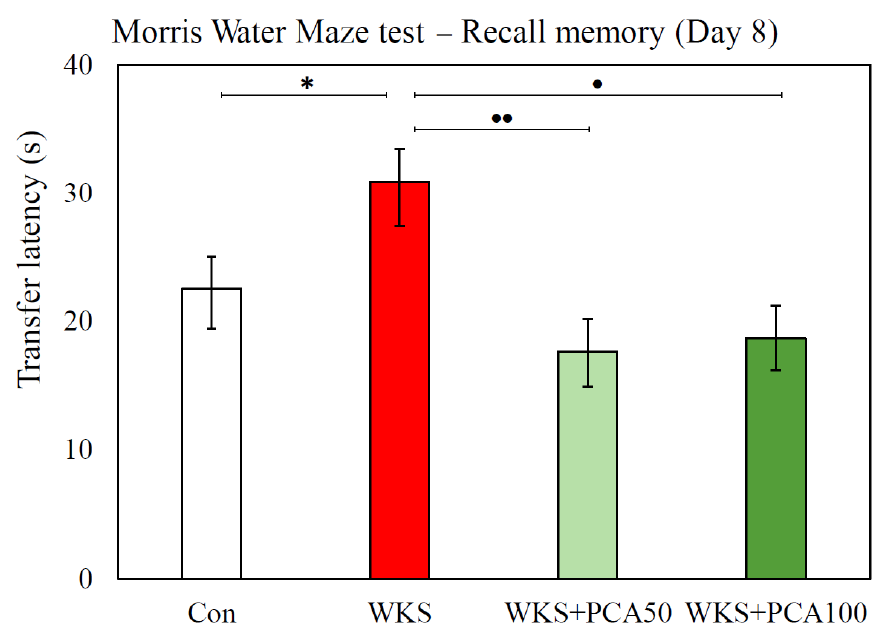
Figure 8. Transfer latency (mean ± SEM) in memory recall task in the MWM test, * p < 0.05 compared to Con, • p < 0.05 compared to WKS, •• p < 0.01 compared to WKS (ANOVA, post-hoc GH).